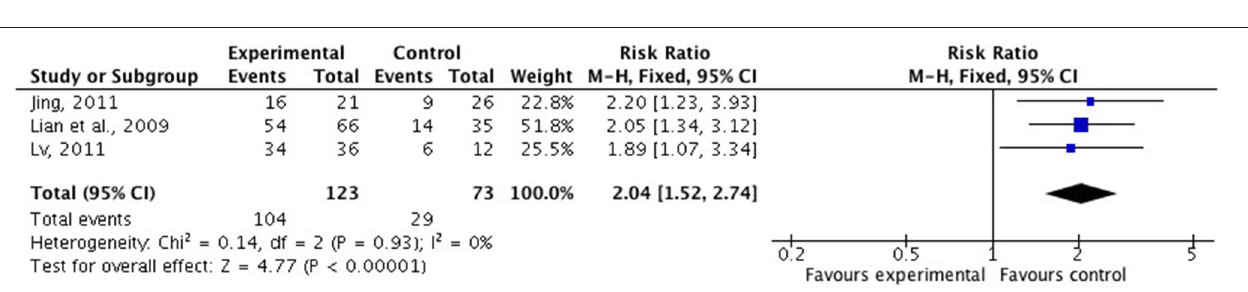
FIGURE 3 | Clinical effective rate of FSZR vs. placebo. FSZR, Chinese formulae that contains suanzaoren.